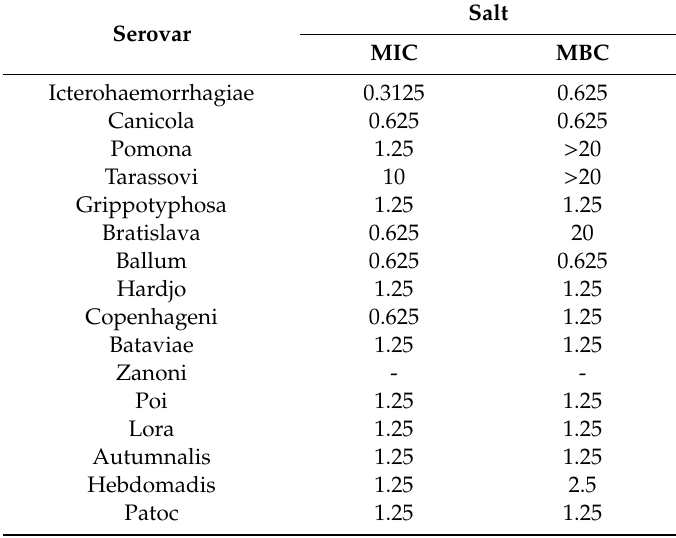
for salt evaluated for the 16 investigated Leptospira spp. strains. Results are expressed as median and values reported in % of salt in Ellinghausen–McCullough–Johnson–Harris (EMJH)